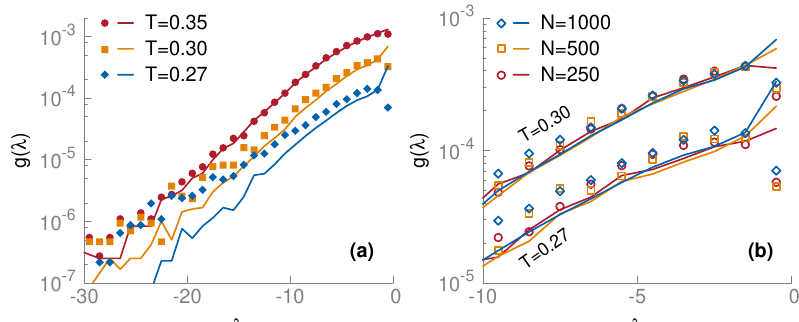
Figure 6: (a) Unstable part of the spectrum g ( λ ) for the ternary mixture from W - minimizations (lines) and EF optimizations (symbols). (b) System size dependence of g ( λ ) for stationary points obtained from EF